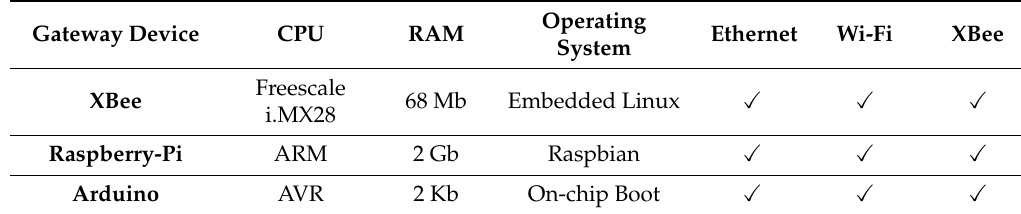
Table 4. Gateways hardware configuration.